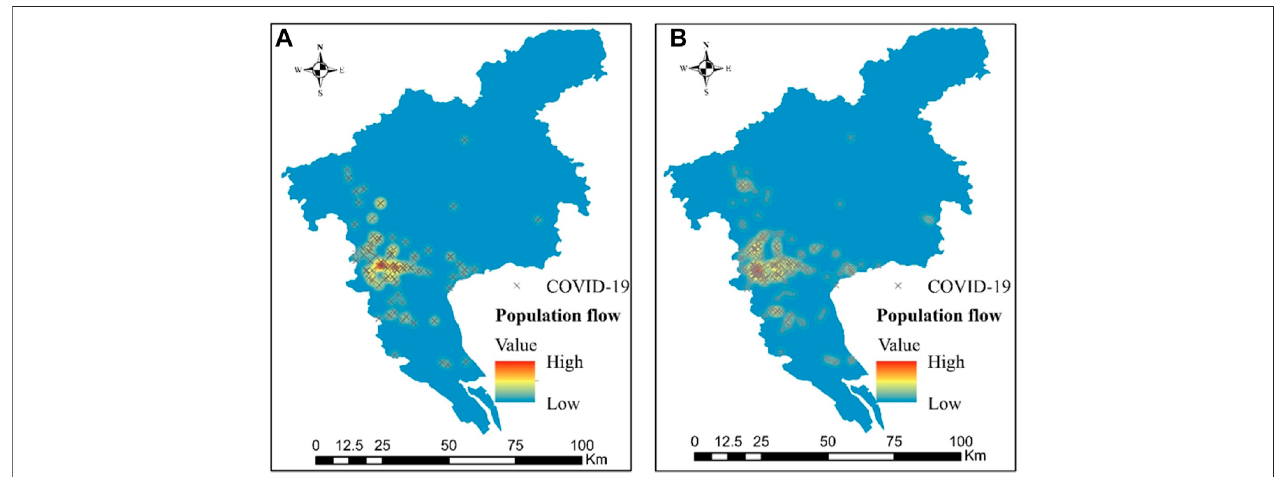
FIGURE 4 | COVID-19 data preprocessing results [ (A, B) Respectively represent the cumulative number and density distribution of COVID-19 infection in Guangzhou in January 2020, in which COVID-19 represents the incidence location, and the color in the fi gure ranges from blue to red, indicating the spatial density distribution of COVID-19 patients varies from high to low].